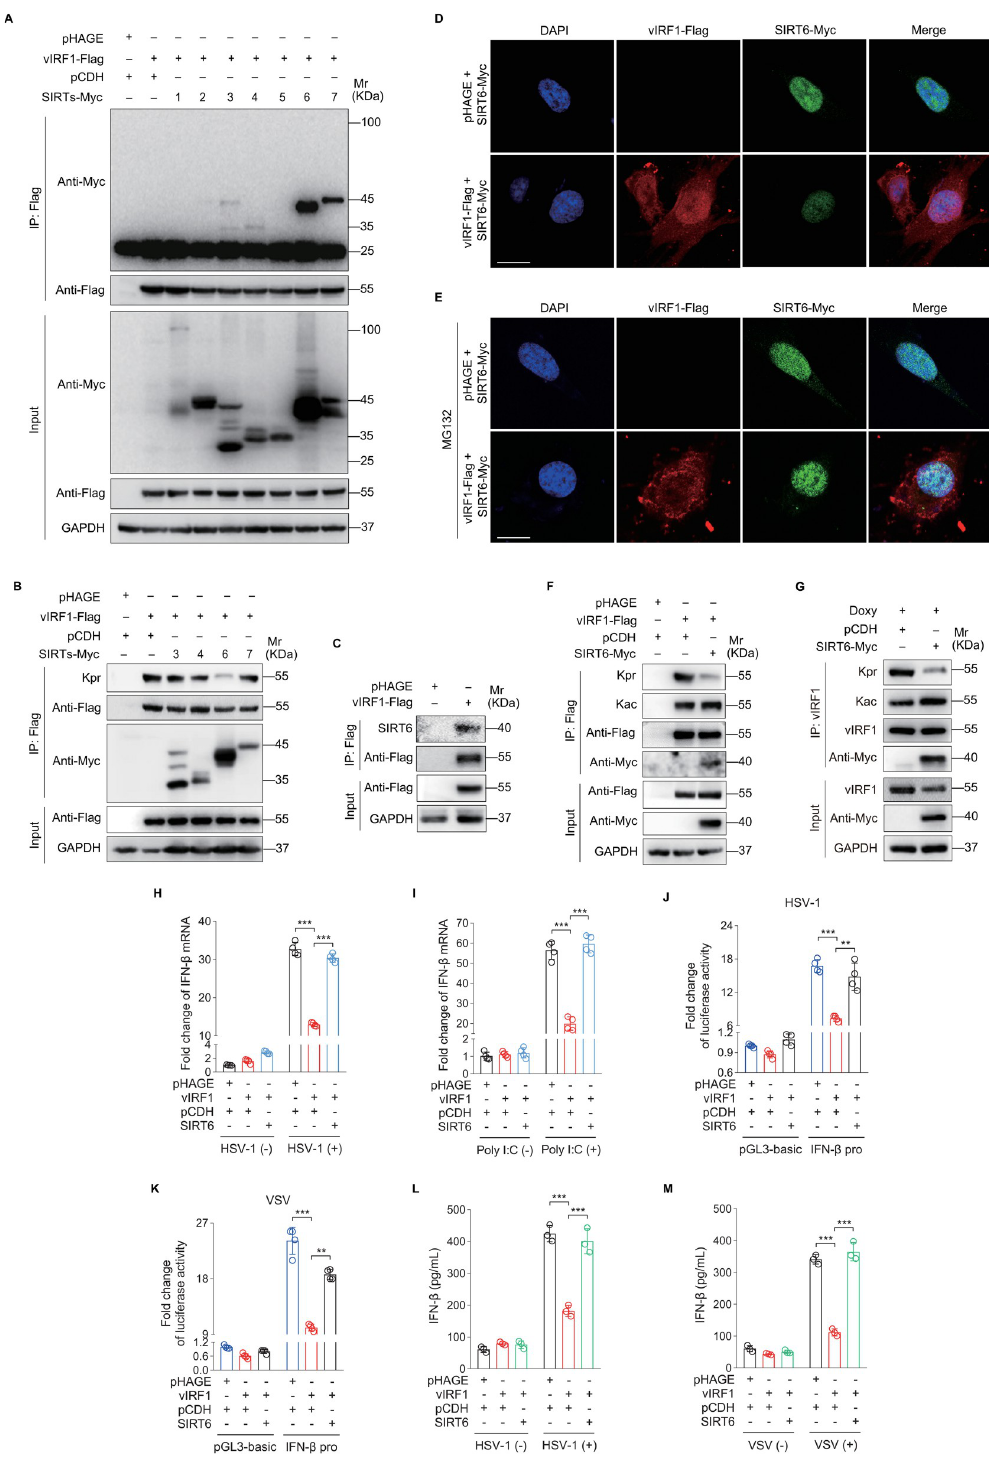
Fig 3. SIRT6 depropionylates vIRF1 to induce IFN- β production. (A). HEK293T cells transduced with lentiviral vIRF1 ( vIRF1-Flag ) or its control ( pHAGE ) were infected with lentiviral sirtuins ( SIRTs-Myc 1~7 ) or its control ( pCDH ), and then subjected to anti-Flag immunoprecipitation. The interaction between vIRF1 and SIRT1~SIRT7 proteins was examined with anti-Myc antibody. (B). HEK293T cells transduced with lentiviral vIRF1 ( vIRF1-Flag ) or its control ( pHAGE ) were infected with lentiviral sirtuins ( SIRTs-Myc 3/4/6/7 ) or its control ( pCDH ), and then subjected to anti-Flag